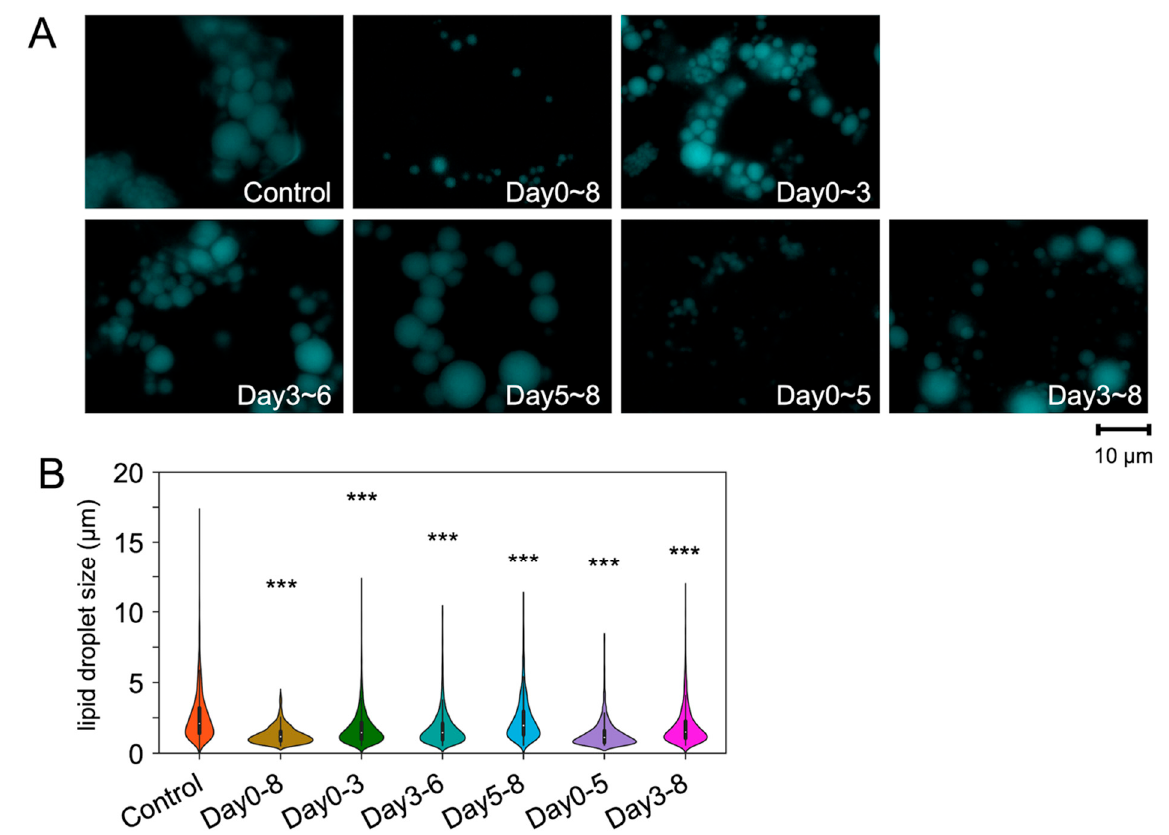
Figure 2. The size of lipid droplets decreased due to PPM1D inhibition in the early stage of differentiation. ( A ) Representative monodansylpentane-stained images of the time-dependent inhibition effect on lipid droplet formation. 3T3-L1 cells were induced to differentiation upon stimulation by MDI, with the addition of SL-176 on the indicated days. ( B ) Size distribution of lipid droplets of 3T3-L1 cells. Violin plot of size distribution of lipid droplets of 3T3-L1 adipocytes. Data were obtained from three independent experiments of 3T3-L1 cells treated with DMSO vehicle (control) or SL-176 (15 µM) for the indicated periods. Significance was analyzed by using Wilcoxon Rank Sum Test. *** p < 0.001, compared with the control group. Table 1. Average size of lipid droplets (LDs) in each